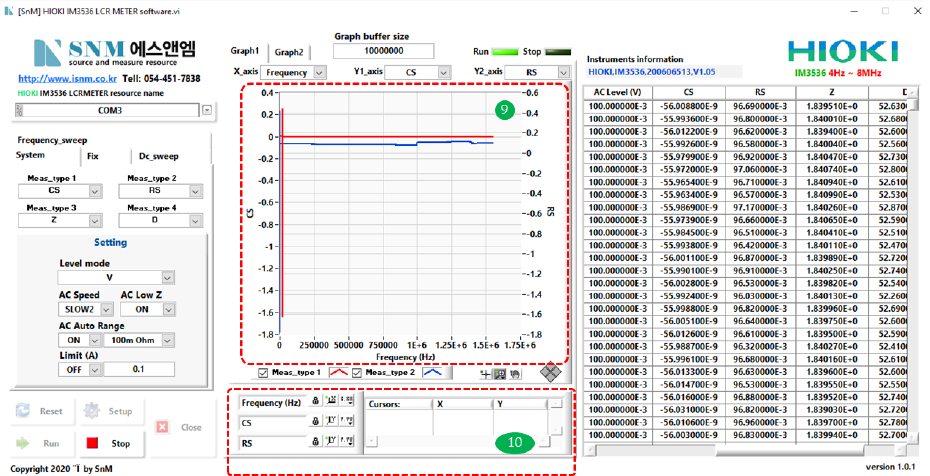
Figure 8. A further description for the computer aided section of 9 and 10 showing the graph display and graph setting/adjustment